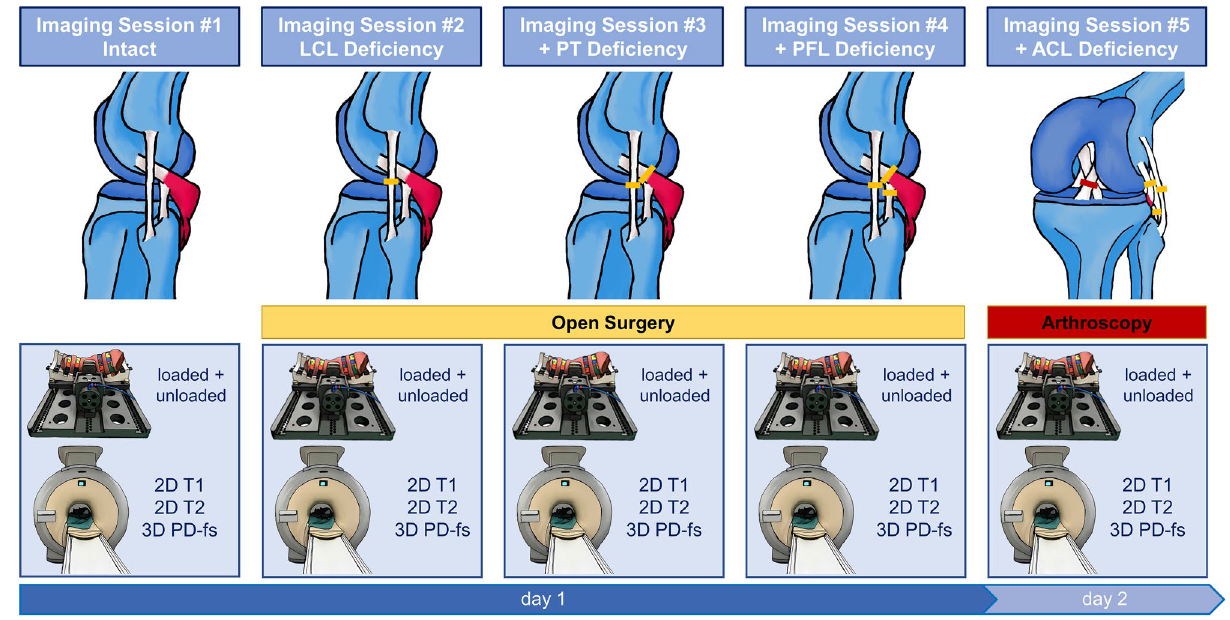
Figure 6. Timeline of imaging sessions as a function of graded injury. The lateral collateral ligament (LCL), the popliteal tendon (PT), the popliteofibular ligament (PFL), and the anterior cruciate ligament (ACL) were transected via open surgical (orange) and arthroscopic approaches (red), respectively. T1-weighted, T2-weighted, and proton density-weighted fat-saturated sequences were used to image the joints in each condition and